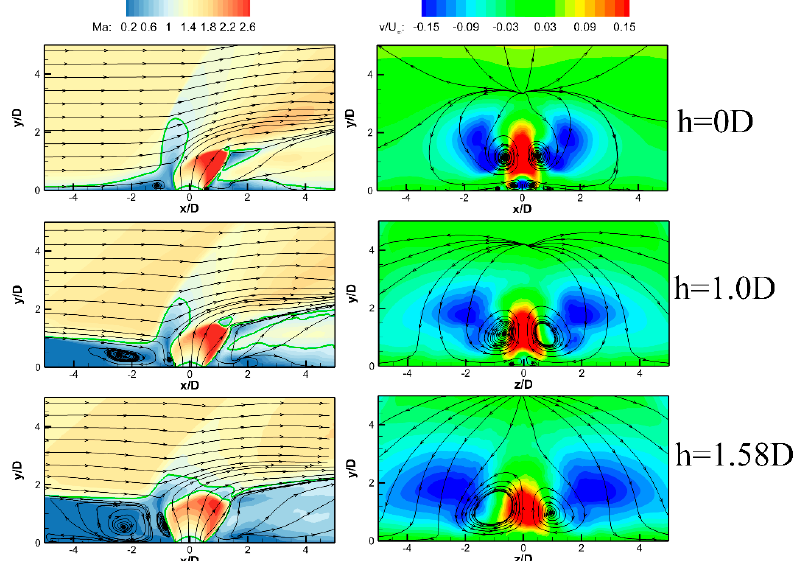
Figure 6. Comparison of the center-plane Mach number with streamlines for cases 1, 2, and 3 ( left ) and the normal velocity with streamlines in axial planes x / D = 4 ( right